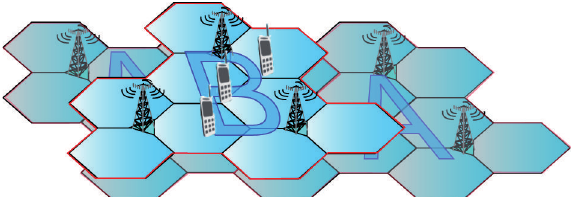
Figure 7: Using overlapping CAs, so-called “cover shifts” can avoid CA edge